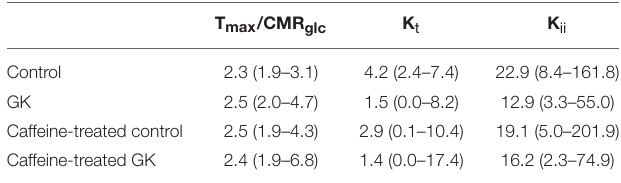
TABLE 2 | Apparent Michaelis-Menten constant (K t ), iso-inhibition constant (K ii ) and ratio of maximal transport rate (T max ) to cerebral glucose consumption rate (CMR glc ) for the glucose transport across the BBB, estimated with the 4-state conformational model from the relationship between hippocampal and plasma glucose concentrations in control, GK, caffeine-treated control, caffeine-treated GK rats (data in Figure 4